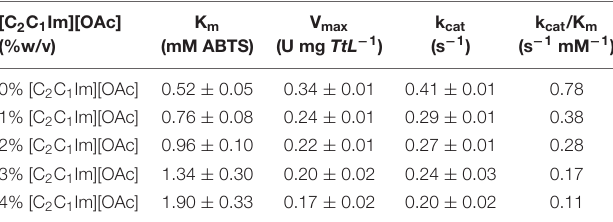
Values shown are mean ± standard error (SE) of three